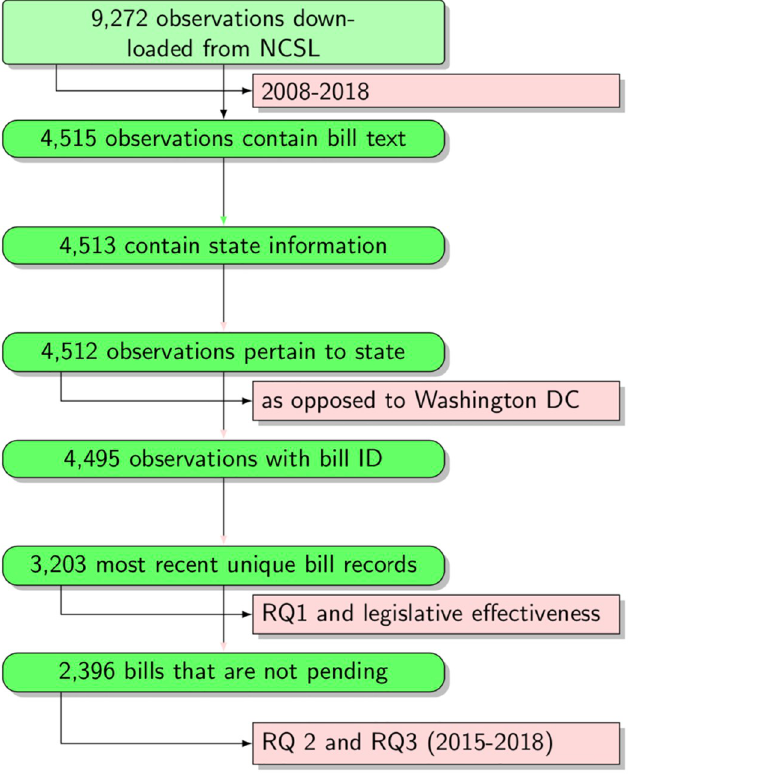
Fig 2. Analytic samples of the